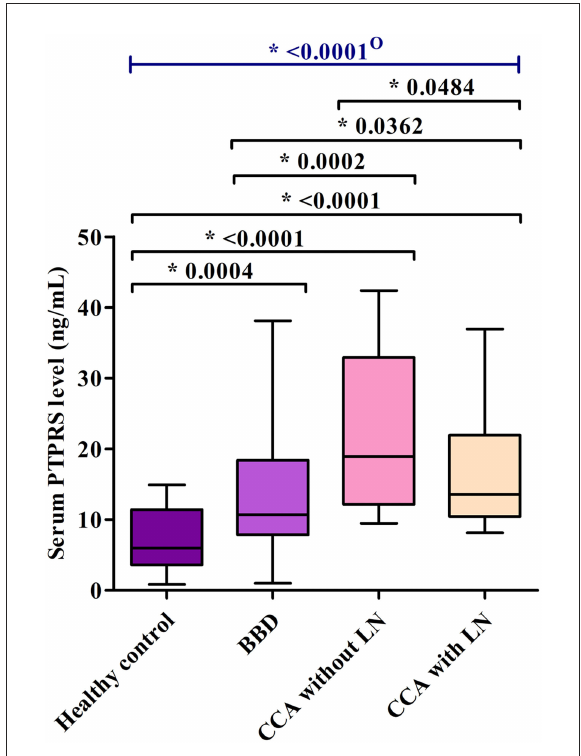
FIGURE2 The comparison of serum PTPRS levels among healthy control group ( n = 55), benign biliary disease (BBD) ( n = 39), CCA without lymph-node metastasis ( n = 38) and CCA with lymph-node metastasis ( n = 38). The comparison was performed using the Mann Whitney U test and the Kruskal-Wallis test because the data distribution of PTPRS level was non-normal. A significant difference ( P < 0.05): O, overall